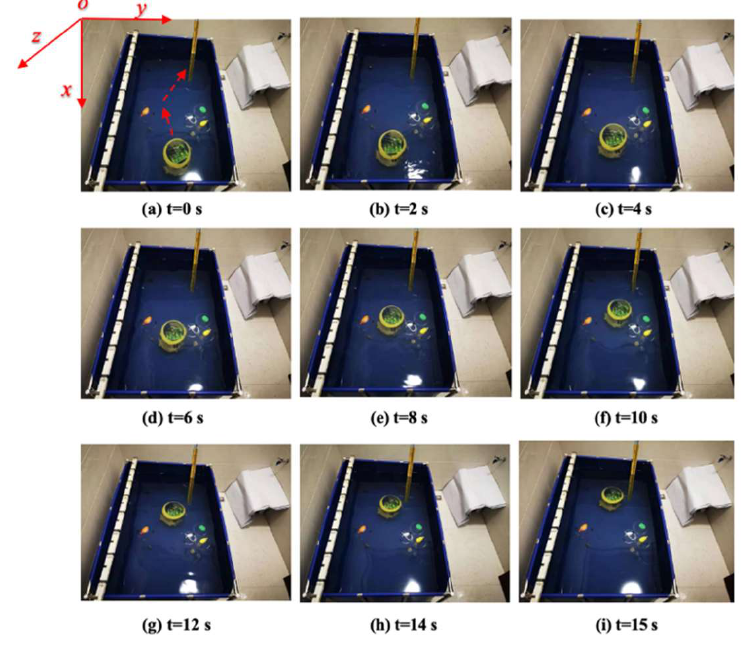
Figure 19. Experiment for passthrough obstacles.